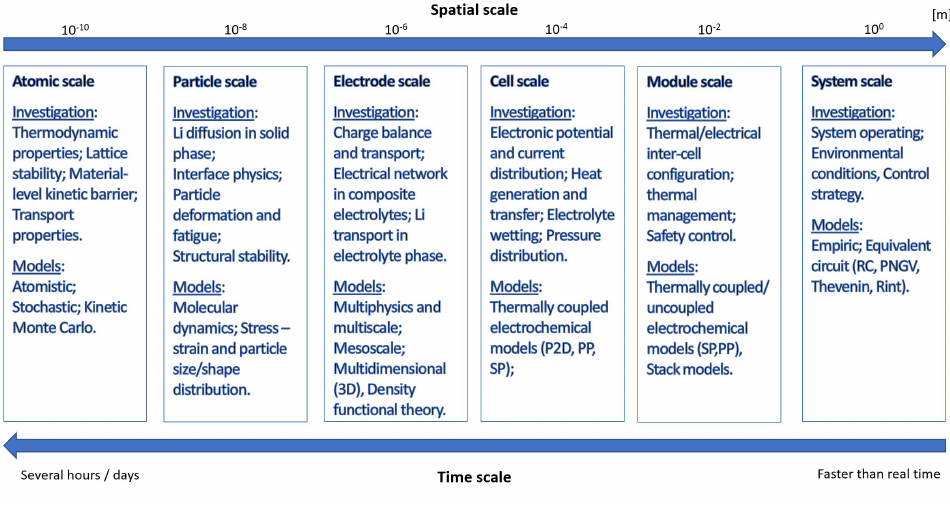
Figure 9. Types of battery models for different design focuses (adapted and data from